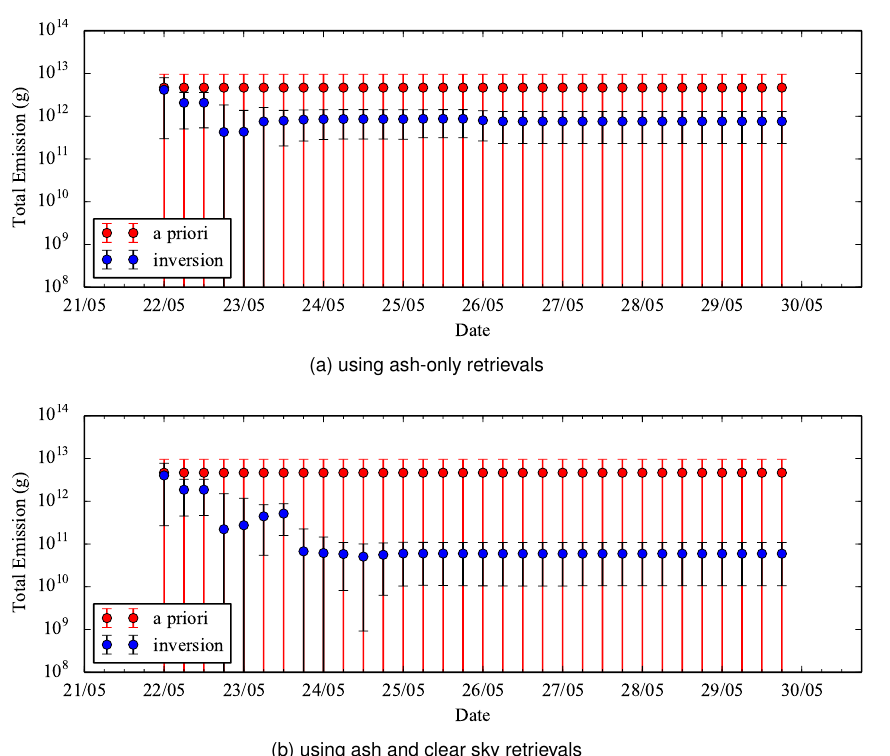
Figure 11. Estimated total ash emissions on 21 May 2011 for the Grímsvötn eruption, showing the changes in the estimates and their error bars as more observations become available over time. Results are shown using ( a ) ash-only and ( b ) ash and clear sky satellite observations. The date indicates the cut-off time for the satellite retrievals used in the